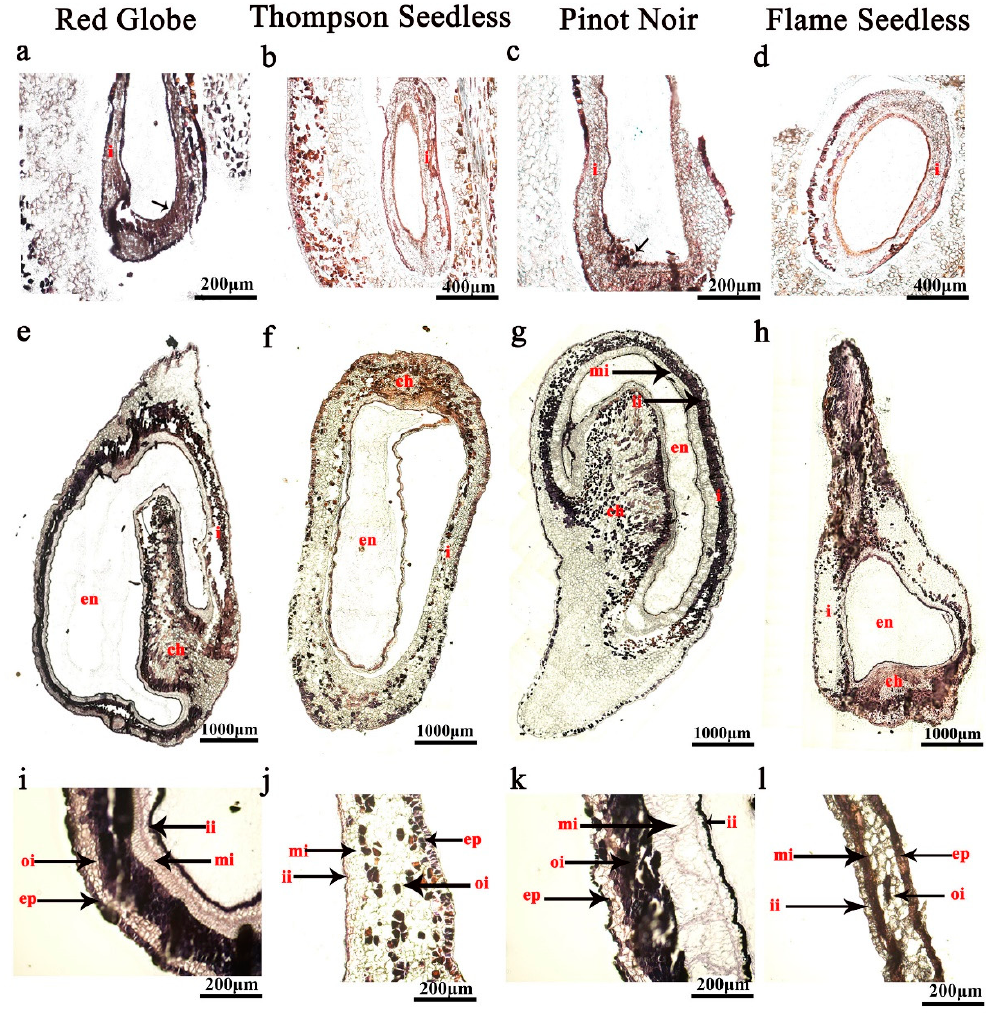
Figure 7. VvTAU expression analysis in grape ovules by in situ hybridisation. ( a – d ): 15 DAF; ( e – l ): 25 DAF; (i: integument; triangular label (ch): chalaza; en: endosperm; ii: inner integument; mi: me ‐ dium integument; oi: outer integument; t: testa; ep: epidermis); DAF: days after flowering. At 15 DAF, VvTAU was expressed mainly in the epidermal cells and integument of the ovule of the seeded cultivars (the ISH signal is evidenced by purple staining and indicated by a black arrow).